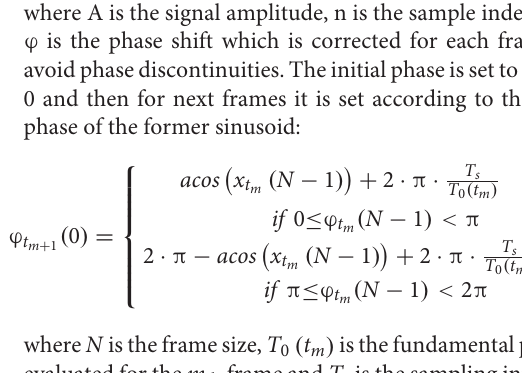
where A is the signal amplitude, n is the sample index, and ϕ is the phase shift which is corrected for each frame